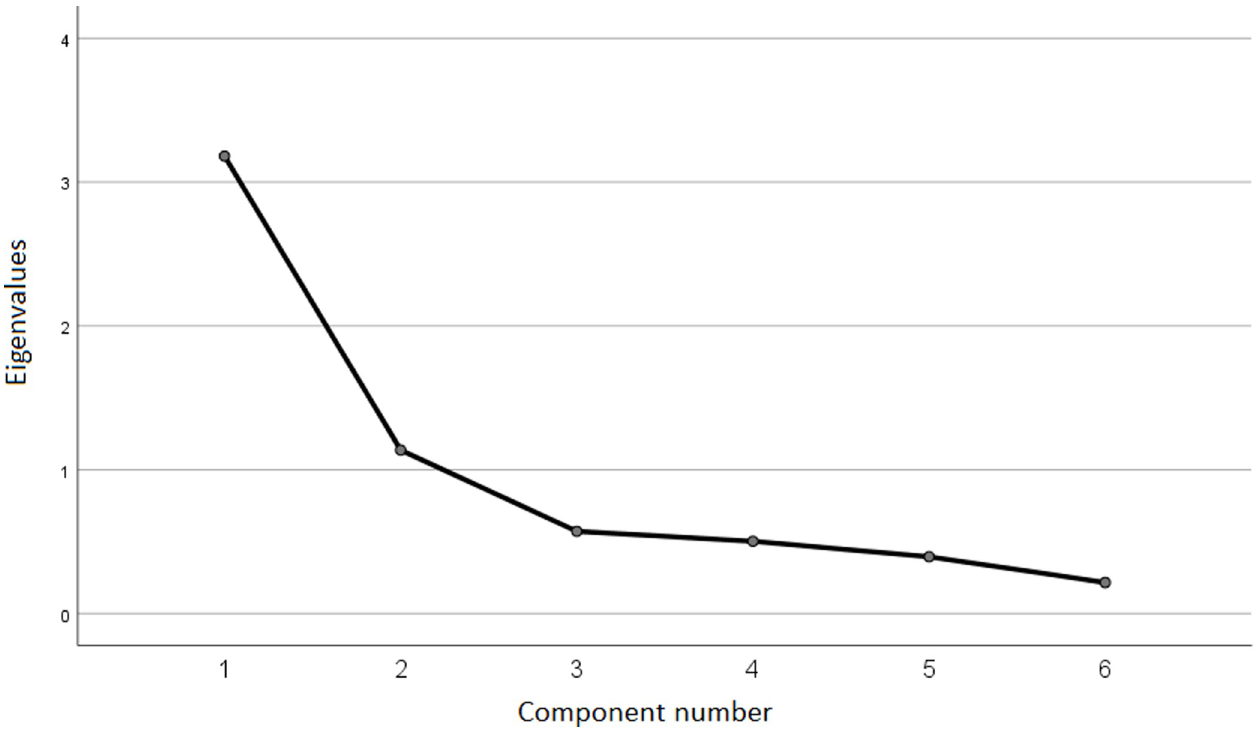
Fig 2. Scree plot obtained via an exploratory factor analysis regarding the dimension of unethical pro-organizational behavior. Source: own work based on the research.